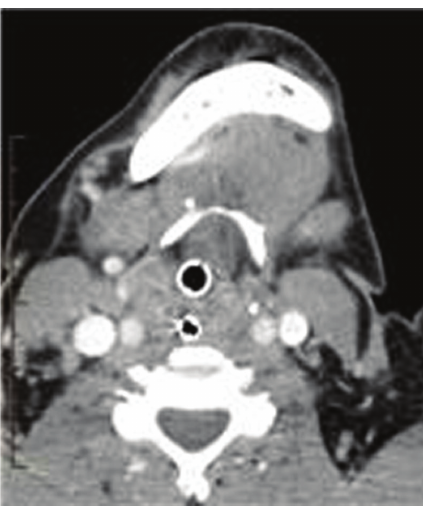
Figure 1: CT scan in the axial plane revealing near-complete airway obstruction at the level of the